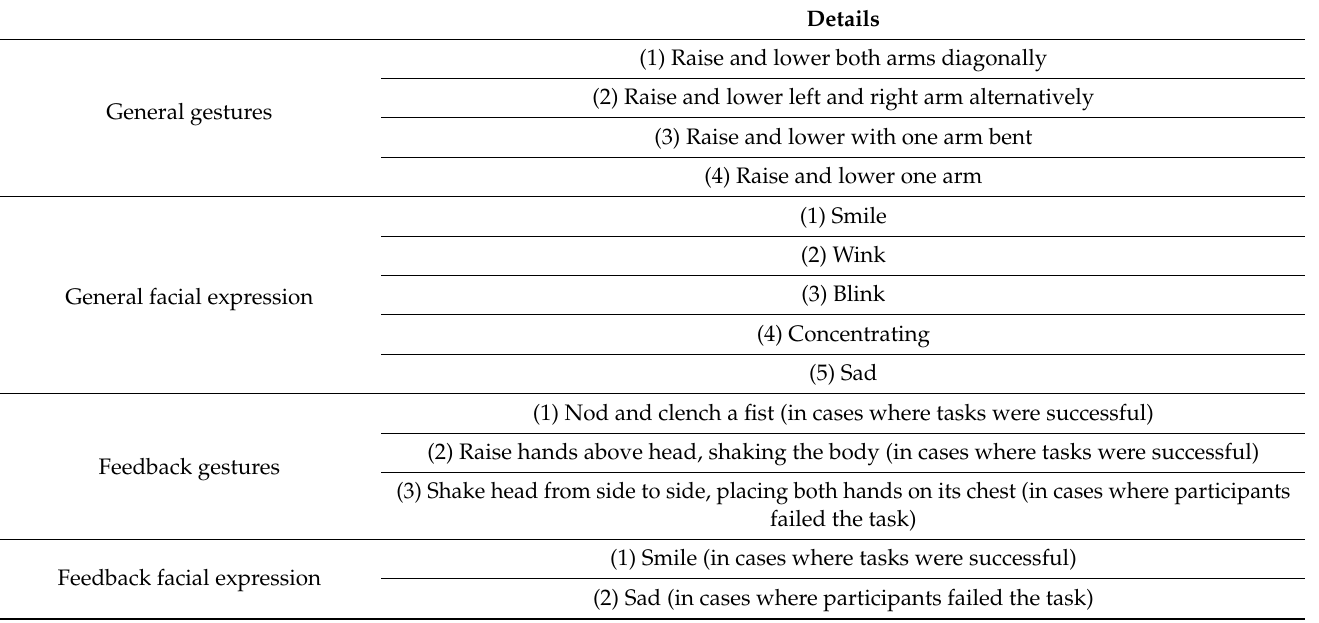
Table 2. Examples of gestures and facial expressions of the humanoid